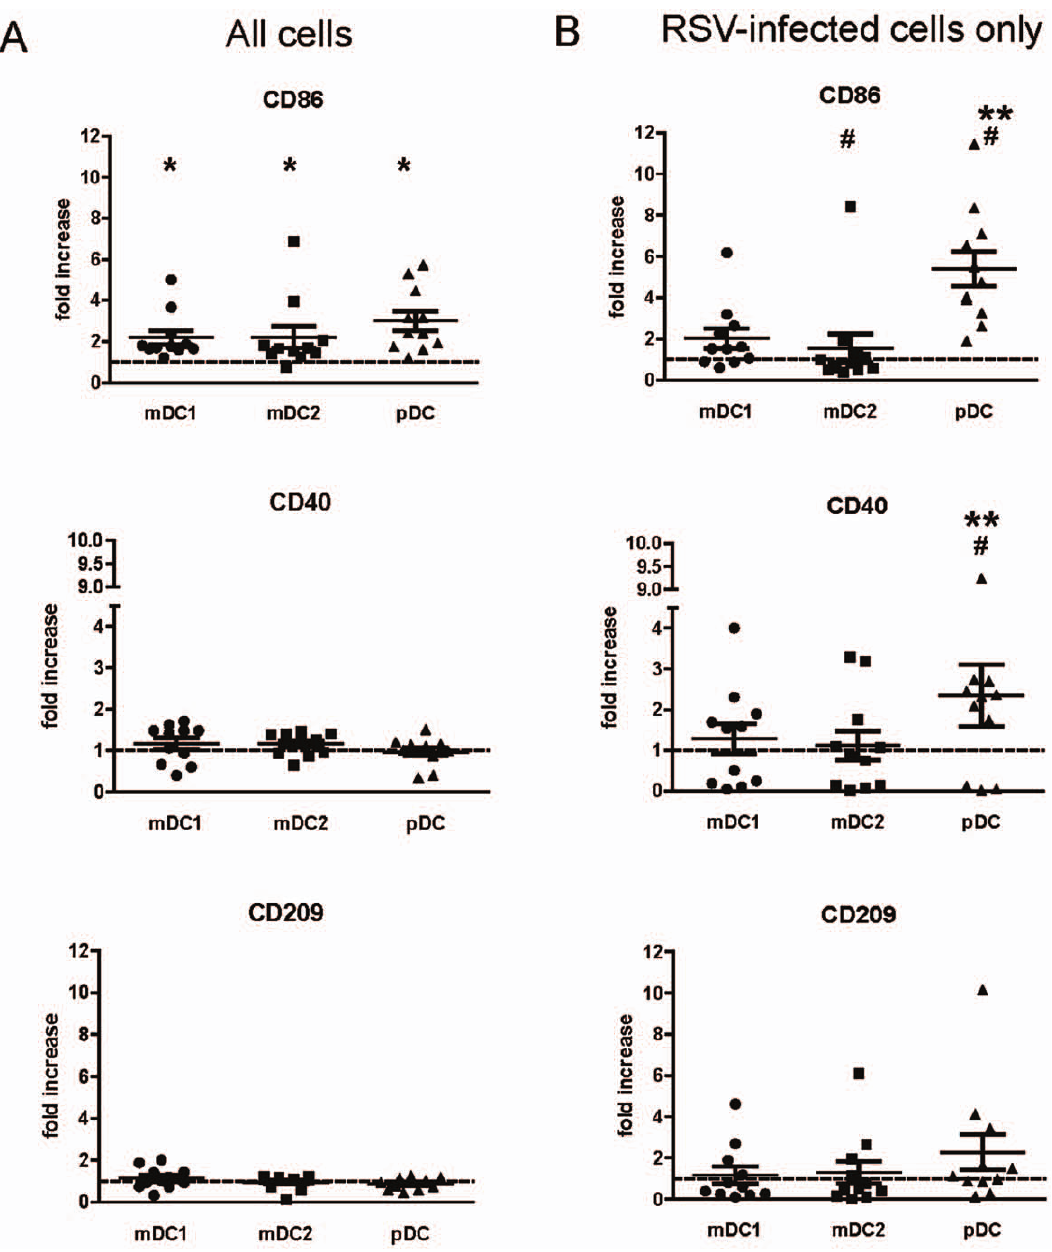
Figure 3. Maturation of RSV-exposed mDC1, mDC2, and pDCs. DC subsets were isolated and infected as detailed in Figure 1. Twenty-four hours after RSV exposure, cells were stained for expression of surface maturation markers and analyzed by flow cytometry. Data are represented as the mean channel fluorescence of RSV-exposed DCs normalized to the mean channel fluorescence of mock-infected cell controls, gating on all live DCs ( panelA ) or on live GFP + cells only ( panelB ). Actual (non-normalized) MFI values for each donor are detailed in Table S3. N=11 with 1 donor present for 2 separate visits. * = significantly different from mock-infected cell of the same type; ** = significantly different from mDC1 and mDC2; # = significantly different comparing total cells and GFP + cells only. p ,